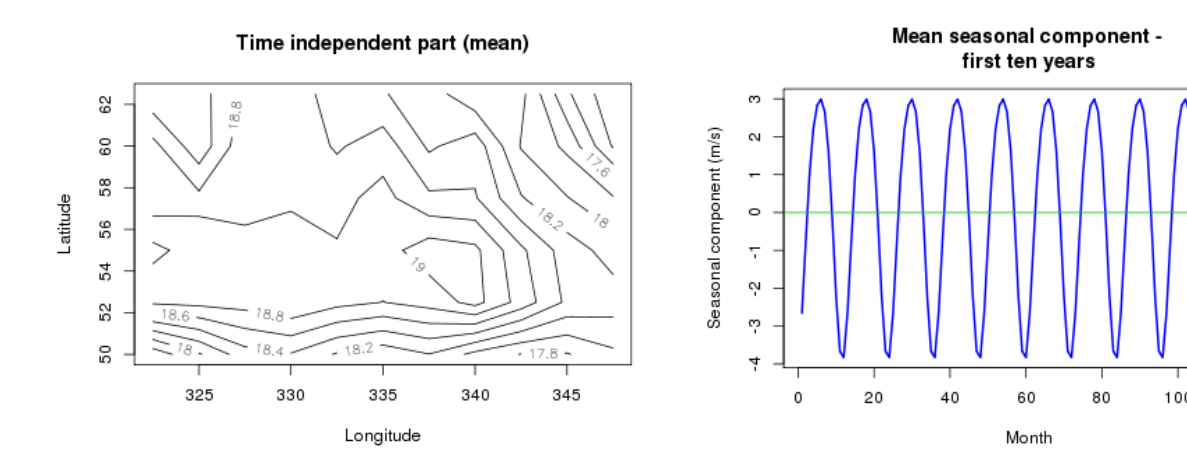
Fig. 9. Results from the model with log-transform of the data: spa- tial field and seasonal factor